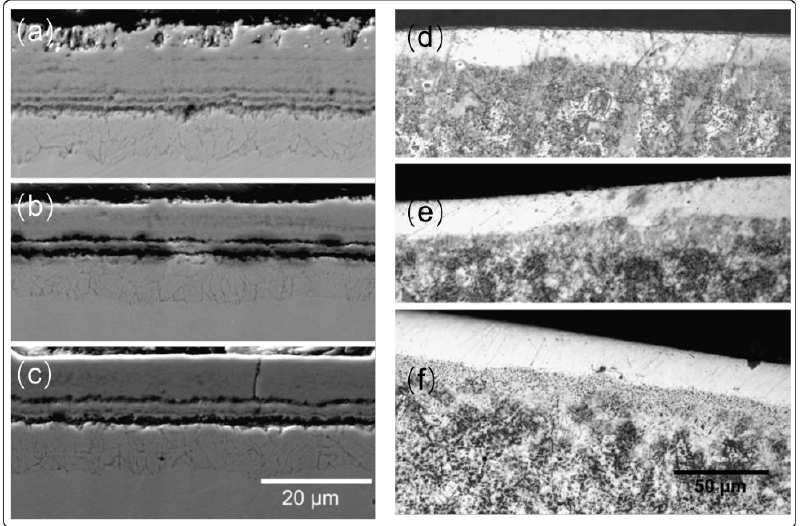
Figure 6. Influence of LBE flowing rate on the corrosion process. ( a – c ) corrosion morphologies of bare T91 after corrosion with flowing rate of 1 m/s, 2 m/s, and 3 m/s, respectively. ( d – f ) corrosion morphologies of surface modified T91 after corrosion with flowing rate of 1 m/s, 2 m/s, and 3 m/s, respectively [69]. Figure 6 is reprinted with permission from [69]. Copyright 2008 Elsevier.